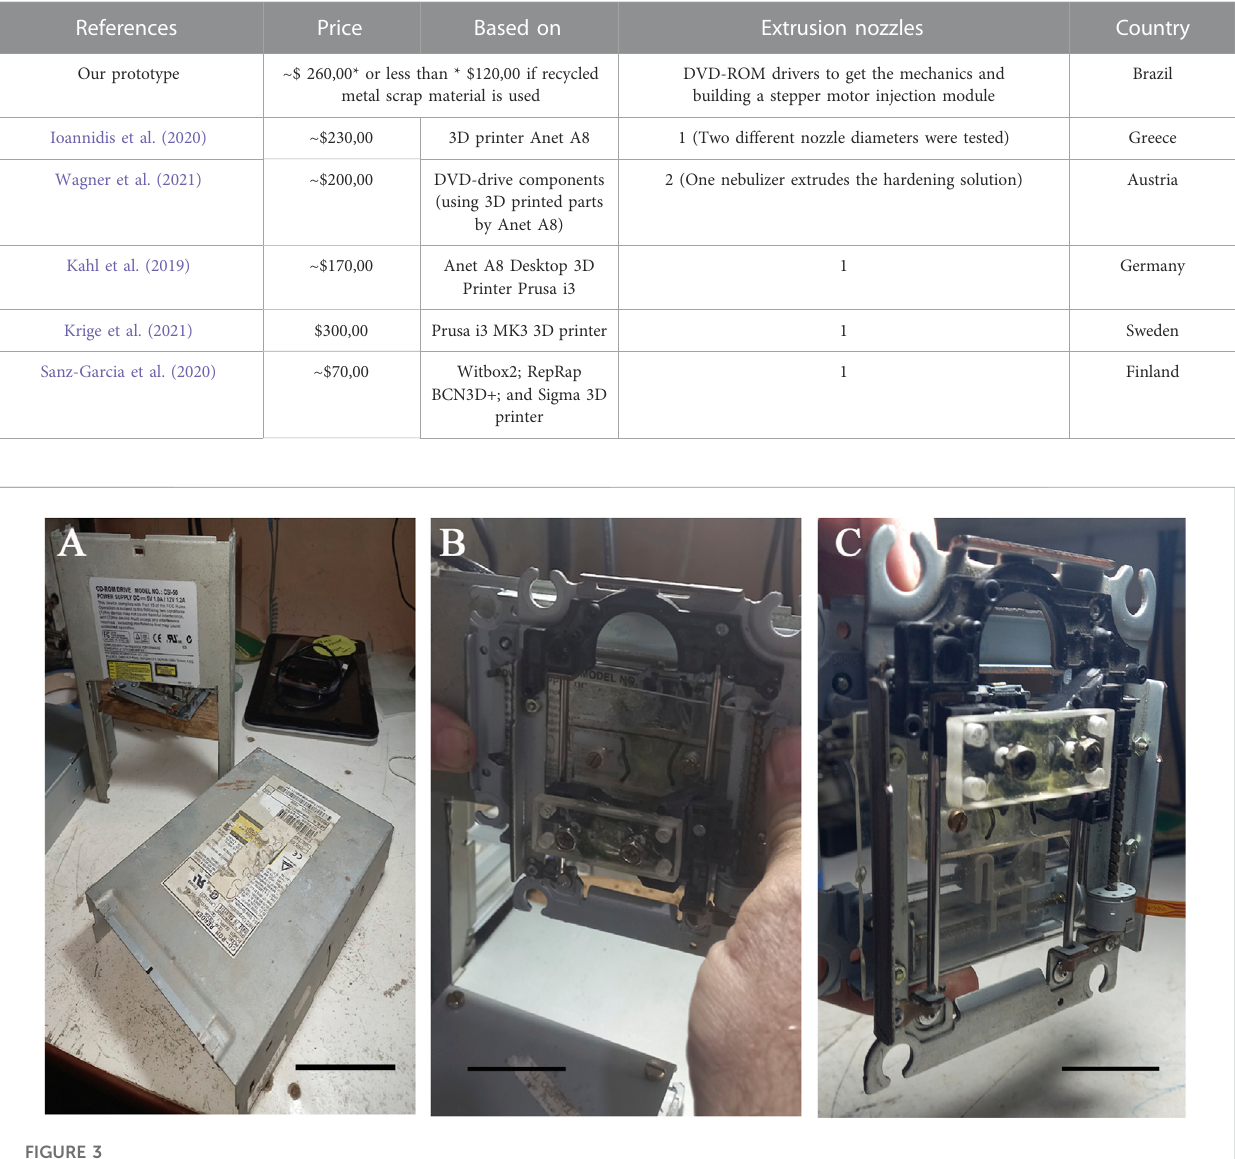
(Figure 6A), with the respective pinout identi fi cation (id. absent